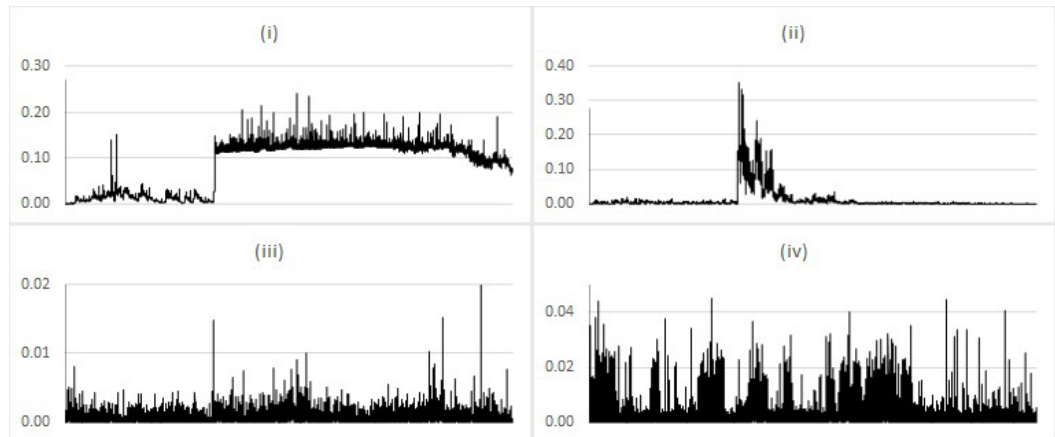
Figure 5. Realised dispersion after re-selection for simulated data with regime change after 10,000 steps, using the Liu and West filter with additional noise term φ equal to ( i ) 0.1